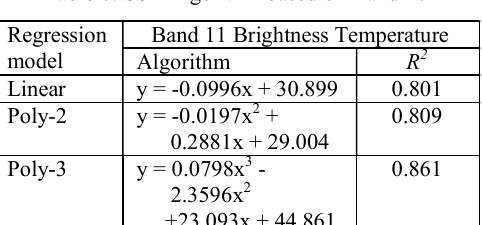
Table 6. SST Algorithm based on Band 10